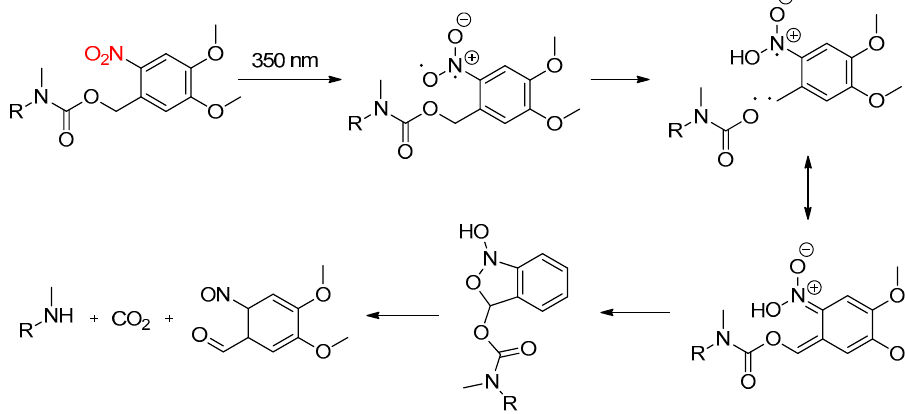
Scheme 9. Reduction mechanism of o -nitrobenzyl derivatives using light.